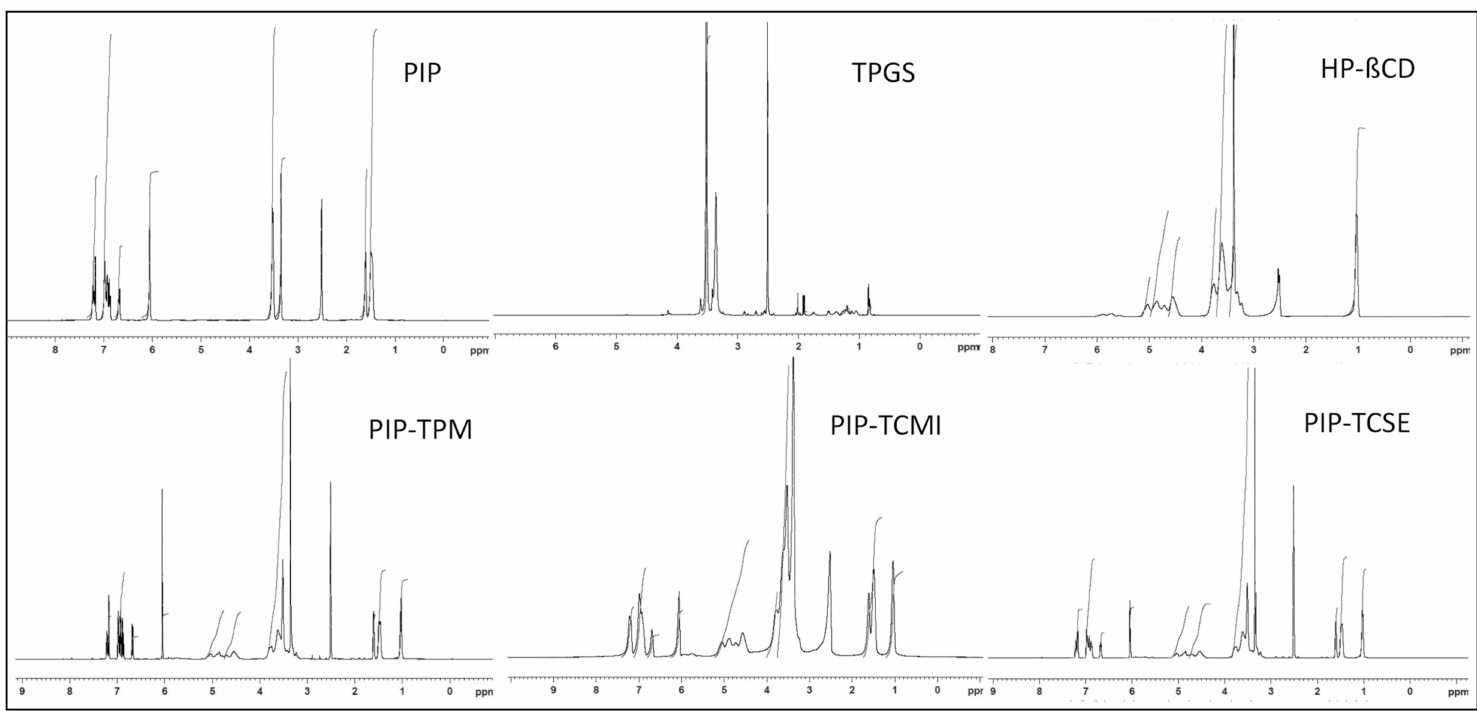
Figure 8. 1 H NMR spectra of pure piperine, HP β CD, TPGS, PIP ternary physical mixture, piperine ternary inclusion complex (microwave irradiation), and piperine ternary inclusion complex (solvent